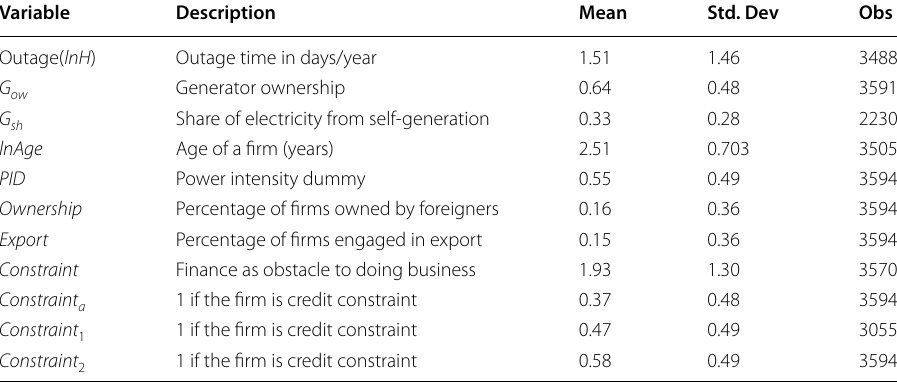
Table 2 Classification of firms by alternative definition of credit constraint